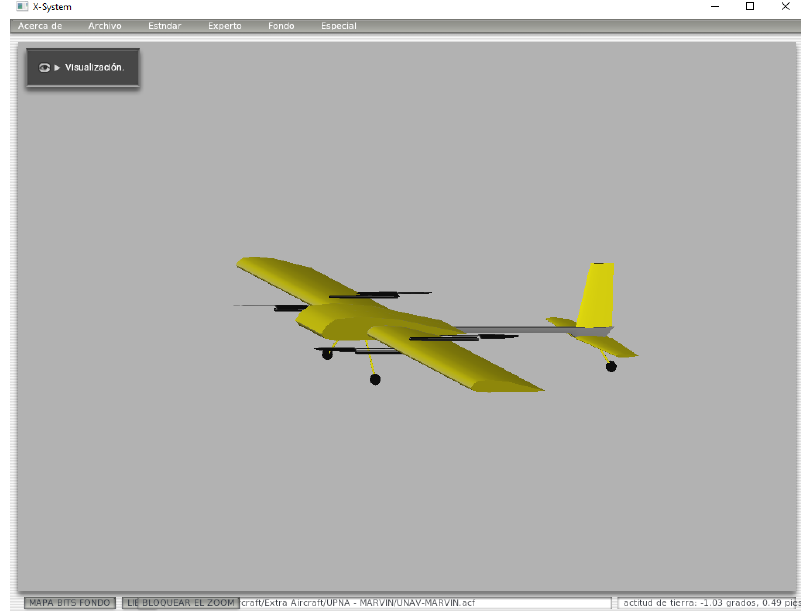
Figure 3. X-Plane’s Plane Maker screenshot featuring the VTOL UAV